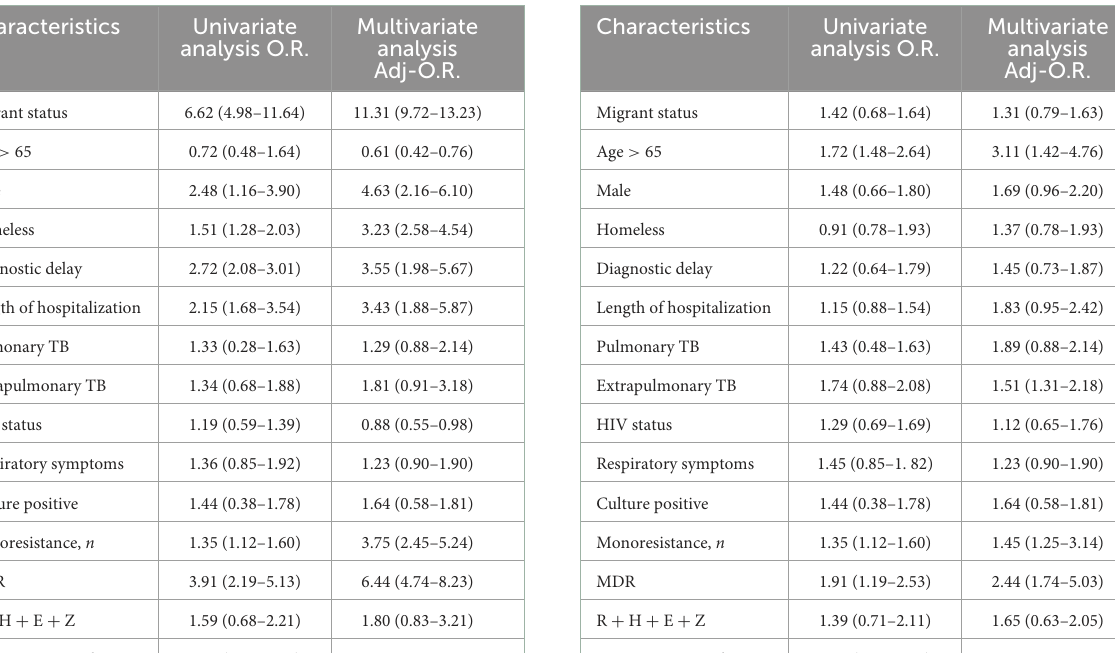
TABLE 2 Predictors of unsuccessful treatment for active pulmonary tuberculosis.